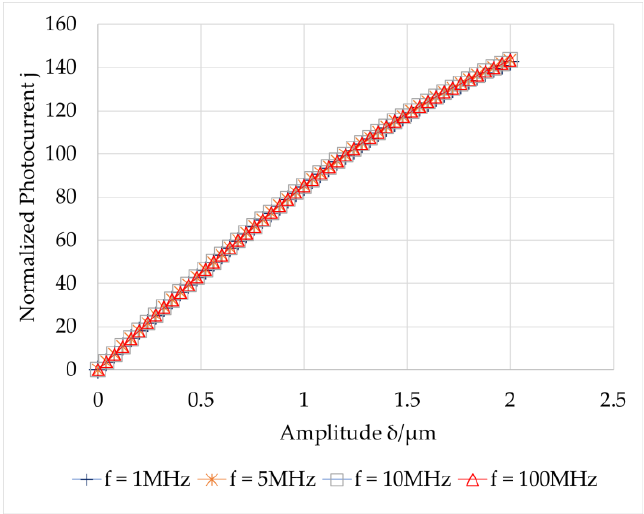
Figure 2. Relation between the photocurrent and vibration amplitude under τ sc Ω >> 1.